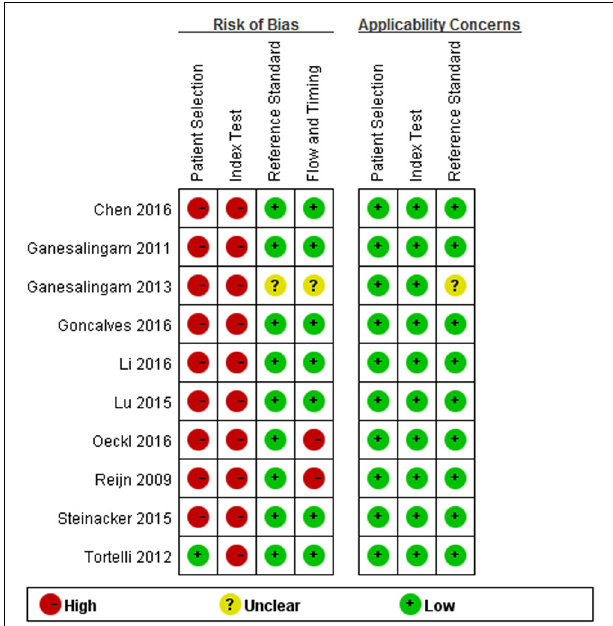
FIGURE 2 | Methodological quality